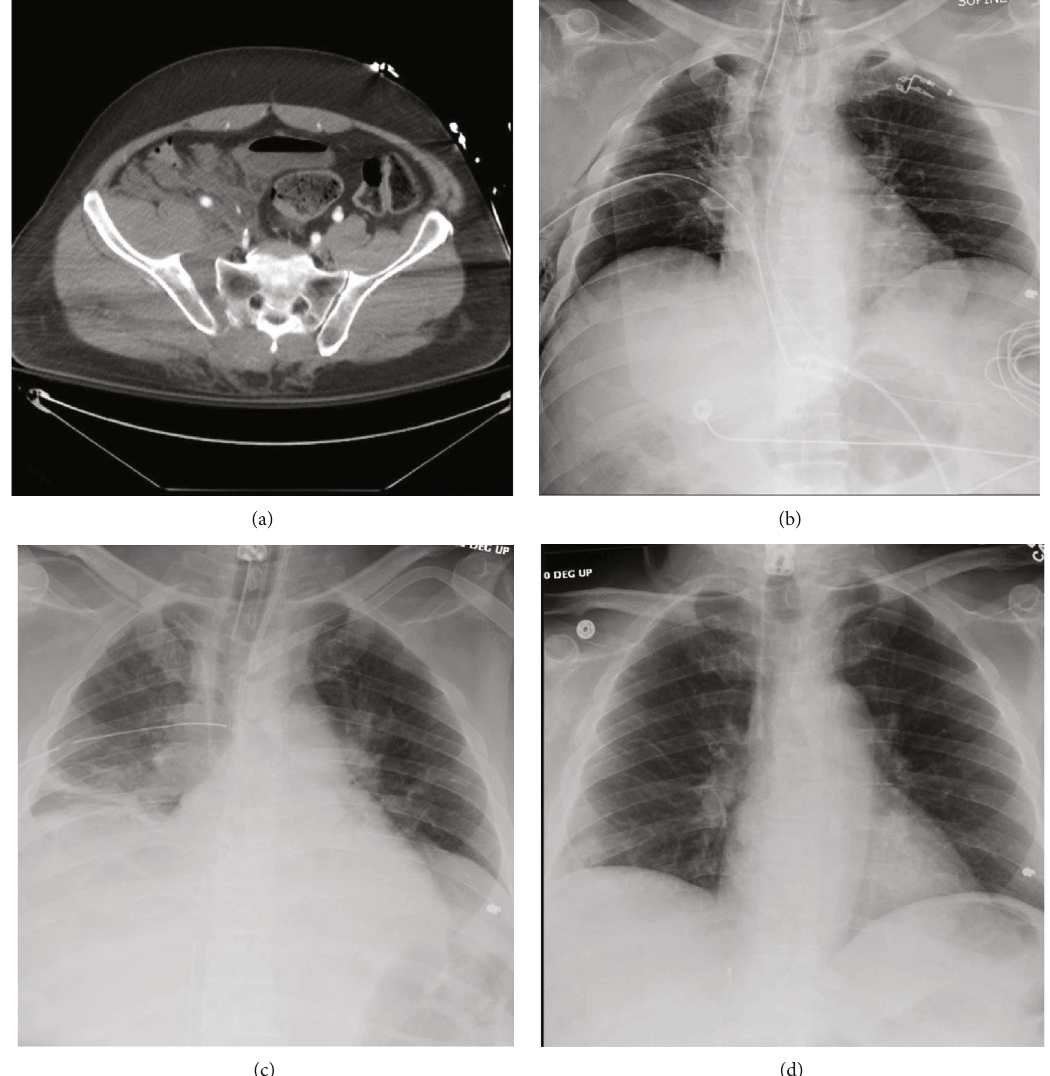
Figure 1: Patient 1 imaging including (a) admission pelvis CT, (b) admission chest X-ray, (c) chest X-ray while on ECMO, and (d) chest X- ray from the time of